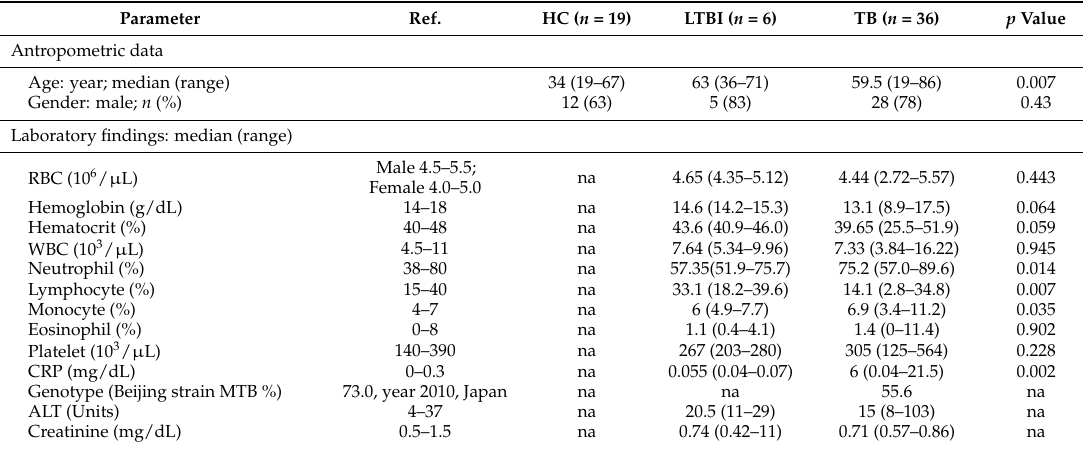
Table 1. Characteristics of HC, LTBI, and TB